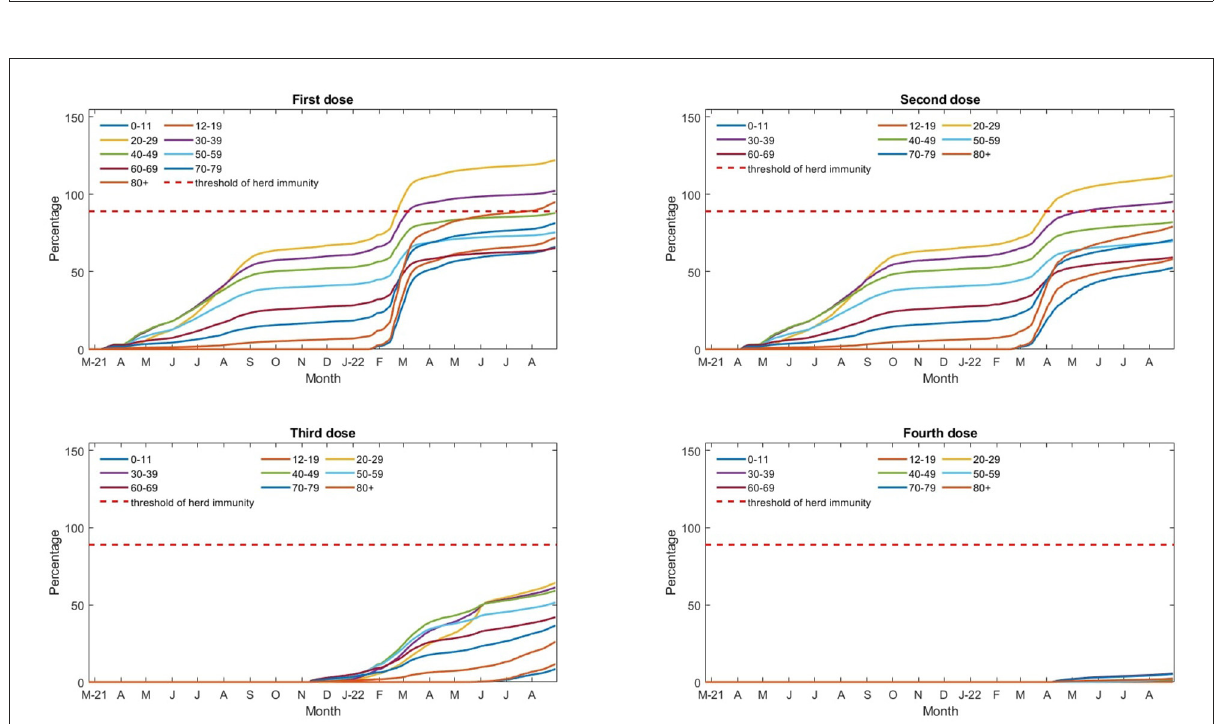
FIGURE2 Vaccination rate for different age groups since 22 February 2021. The vaccination rate includes non-Hong Kong residents, such as holders of the Exit–Entry Permit for Traveling to and from Hong Kong and Macao with complete two doses of vaccination within their stay limit without extension, non-refoulement claimants and refugees, and other visitors staying in Hong Kong. The vaccination rate may be greater than 100% for some age